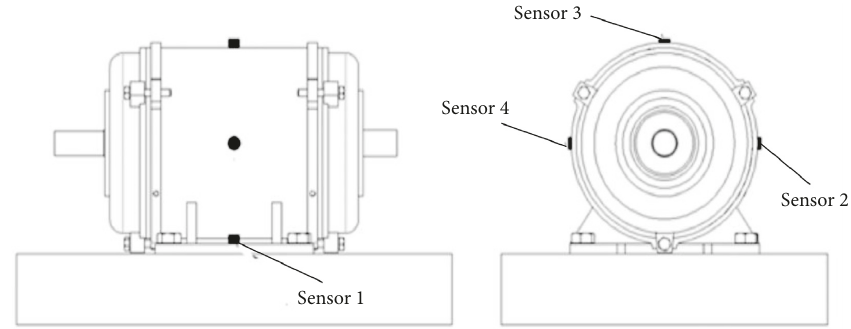
Figure 11: Arrangement of the acceleration sensor.